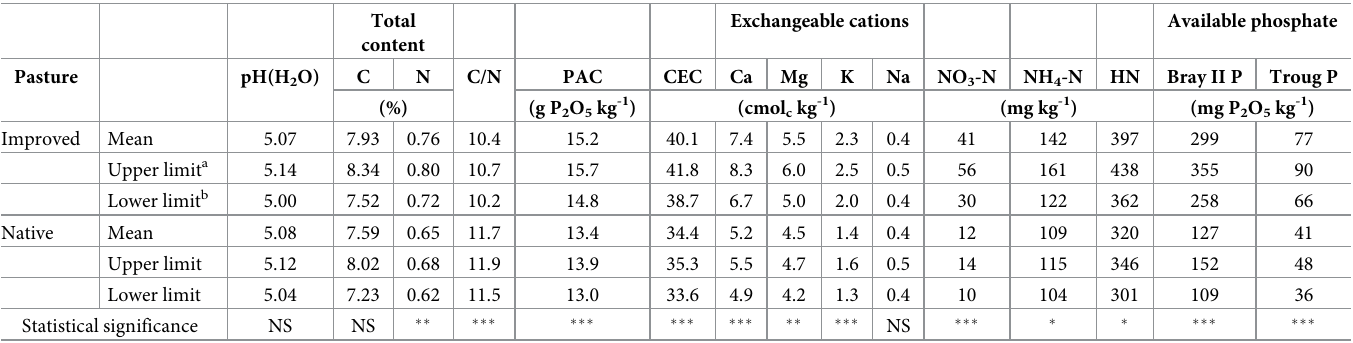
Statistical significance Abbreviations: PAC—phosphate absorption coefficient, CEC—Cation exchange capacity. HN—Hot-water-extractable N. a Upper limit of 95% confidence interval. b Lower limit of 95% confidence interval. � p < 0.05 ��